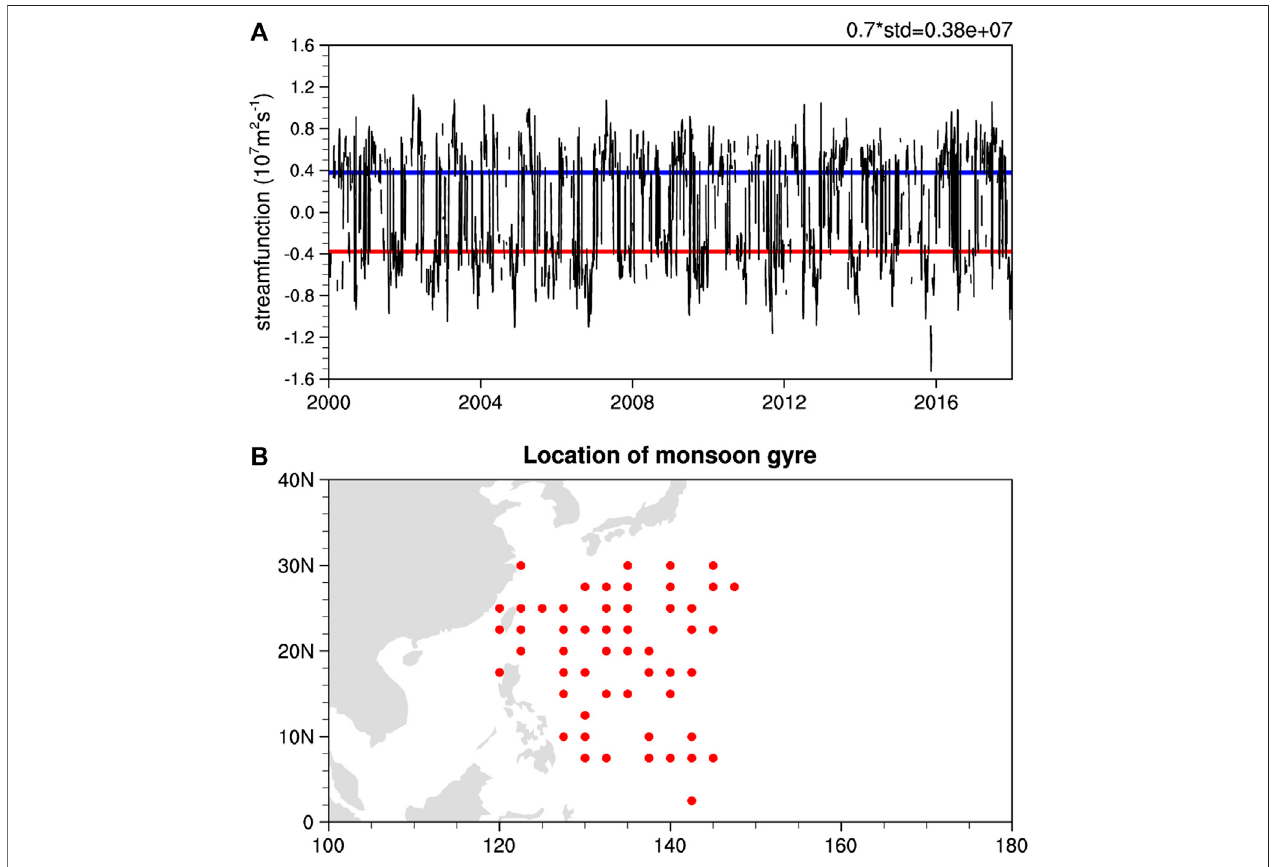
FIGURE2|(A) Thedailyextremevalueofstreamfunctionwithwavenumbers4 – 7intheregionof(0 ° – 30 ° N,120 ° – 150 ° E)inMay – Octoberduring2000 – 2018,where the blue and red horizontal lines in (A) are positive and negative 0.7 times the standard deviation of extreme value of streamfunction, respectively; and (B) Locations of MG centers in the same period.